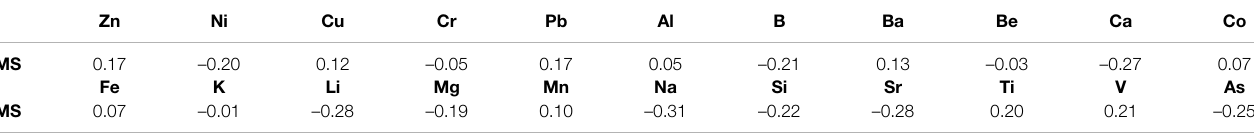
TABLE 6 | Vlasina sediments — correlations between MS and studied elements.